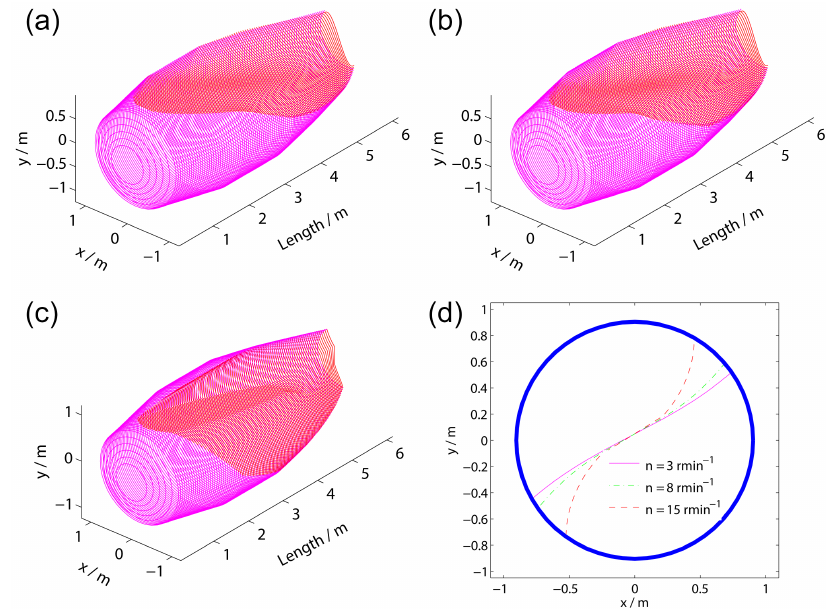
Figure 4. Shapes of the concrete with different speeds. (a) β = 12 ◦ , n = 3rmin − 1 . (b) β = 12 ◦ , n = 8rmin − 1 . (c) β = 12 ◦ , n = 15rmin − 1 . (d) Concrete section shape ( z = 4647mm).